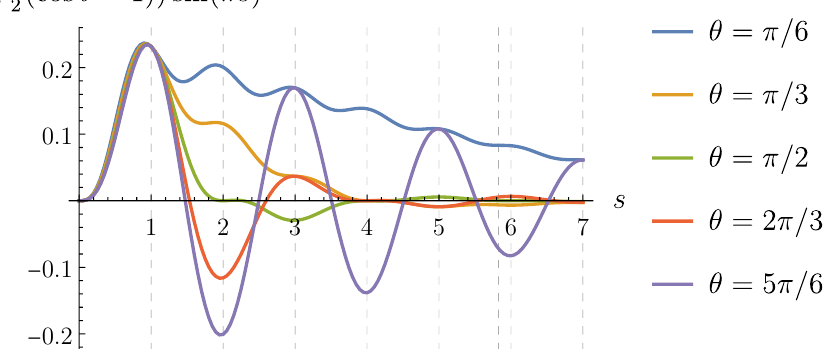
( s , t ) for few valued of scattering angles θ related to Mandel- Figure 26: Plot of Im A p an stam invariants by cos θ = 1 + 2 t / s , multiplied by sin ( π s ) 2